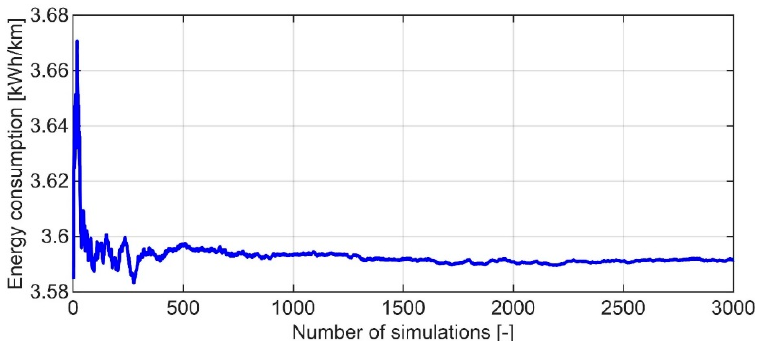
Figure 11. Overall average energy consumption of the diesel bus model versus number of simulated synthetic cycles.